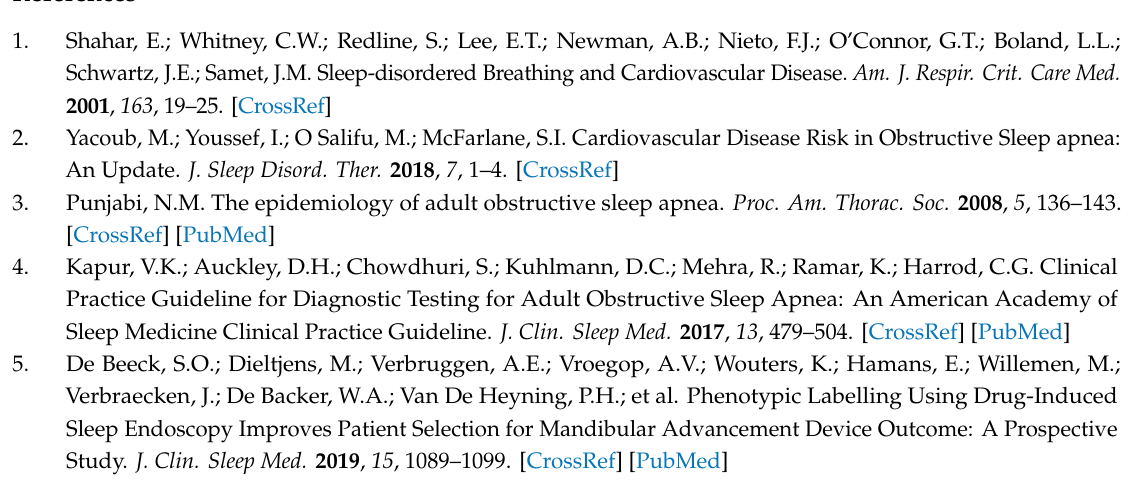
Table S1: STROBE Statement—checklist of items that should be included in reports of observational